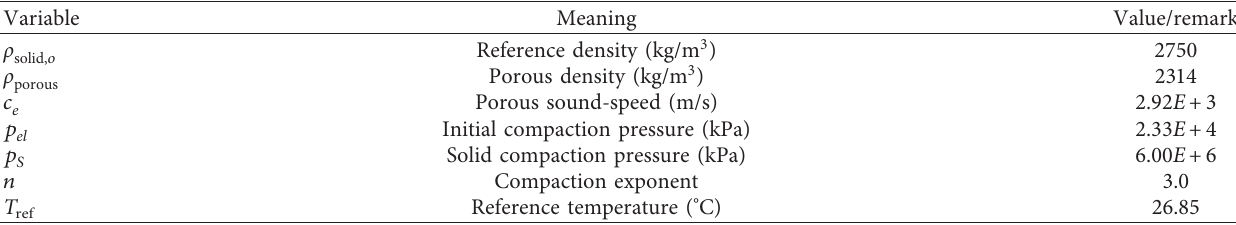
Table 1: P-alpha EOS input parameters for C-35 concrete.